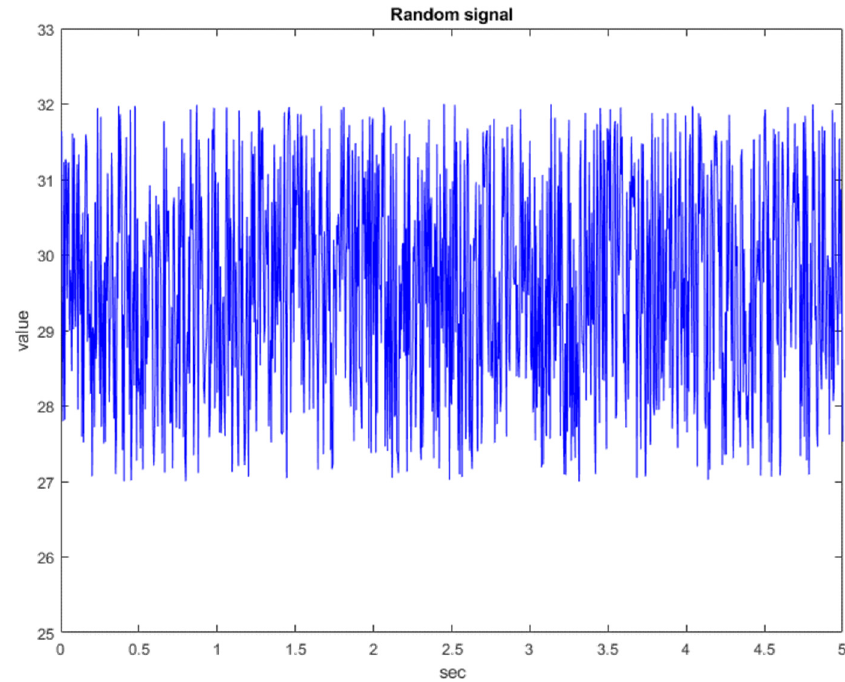
Figure 9. The random signal graph. Next, the random signal is encrypted with the state of the chaotic system, as shown in Figure 10. The blue line is the original random signal and the black line is the encrypted signal. As we can see from Figure 10, the original signal has been completely